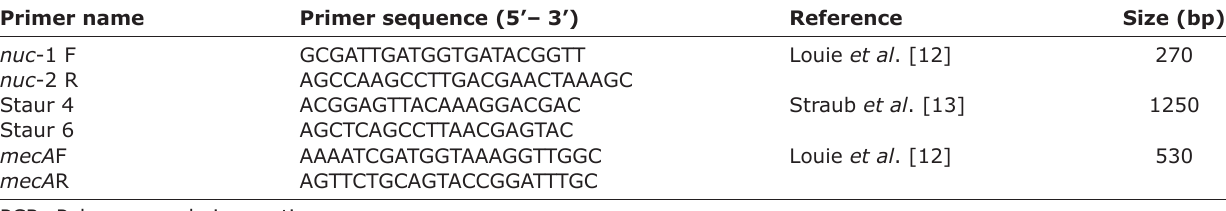
Table-1: The sequence of the primers for PCR amplification specific to different genes of Staphylococcus